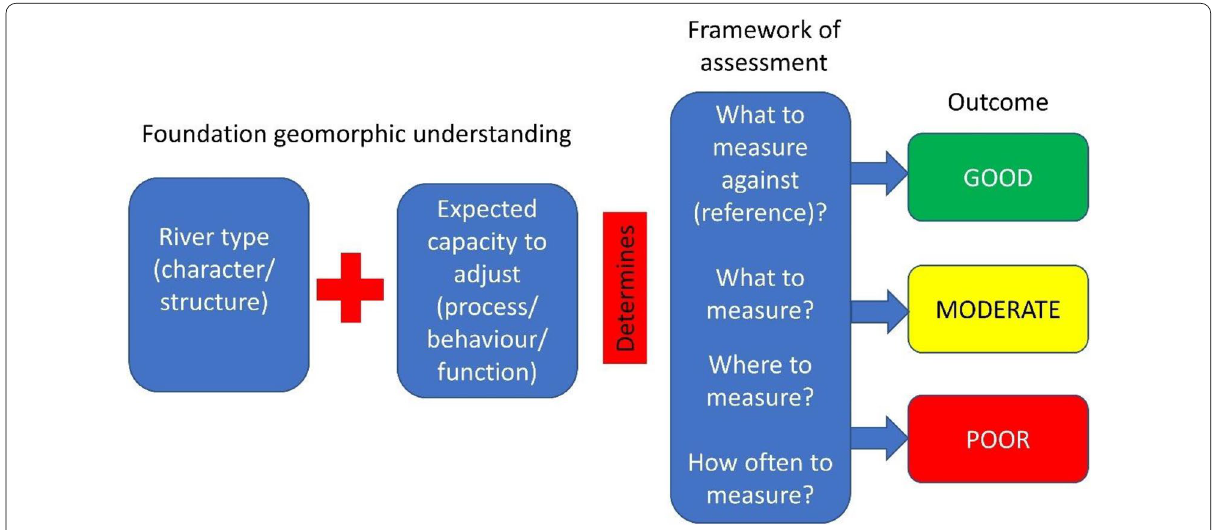
Fig. 5 Approach to assessment of geomorphic river condition (after Fryirs